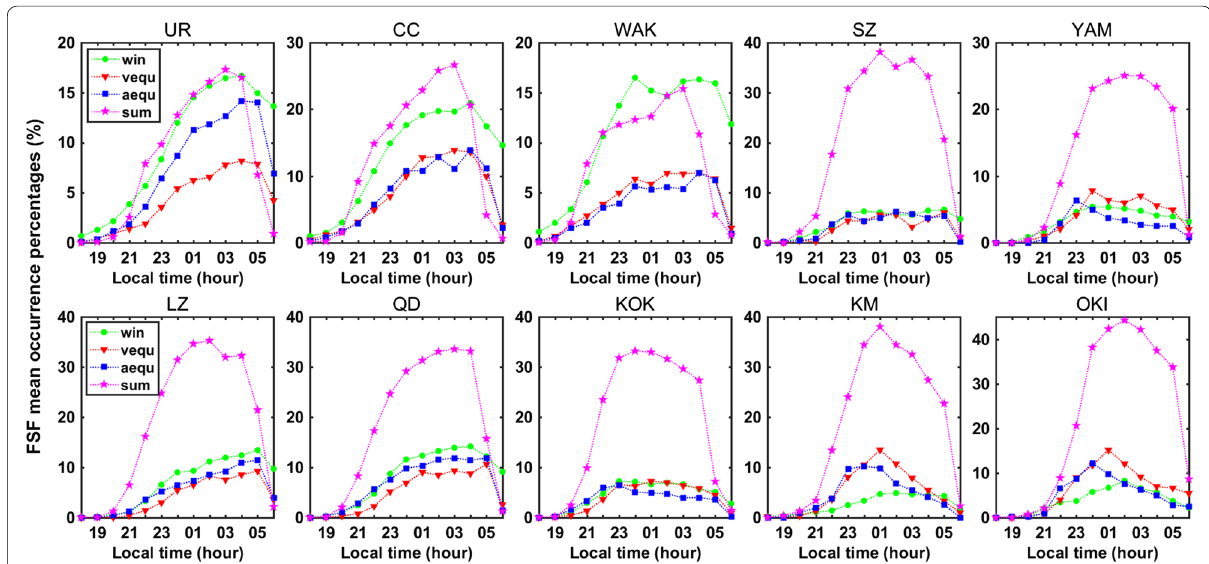
Fig. 10 Seasonal variations in FSF mean occurrence percentages; green, red, blue and magenta lines represent winter, vernal equinox, autumn equinox and summer, respectively